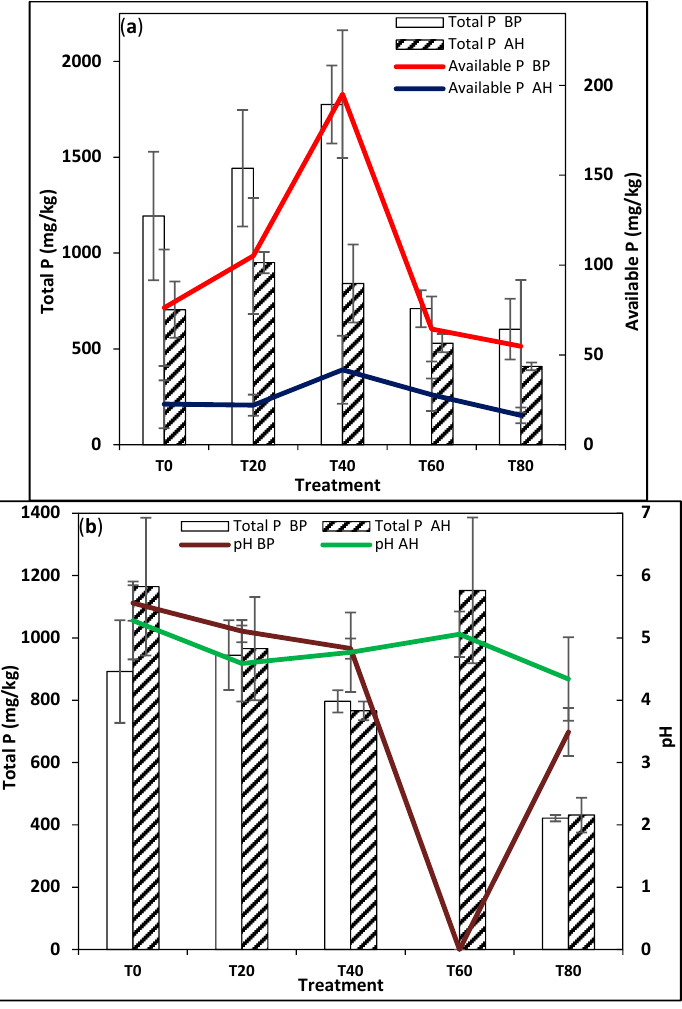
Figure 4. Time and treatment effects on ( a ) total P and available P of rainforest soils cultivated with Amaranthus cruentus and ( b ) on pH and total P of rainforest soils cultivated with Solanum macrocarpon .